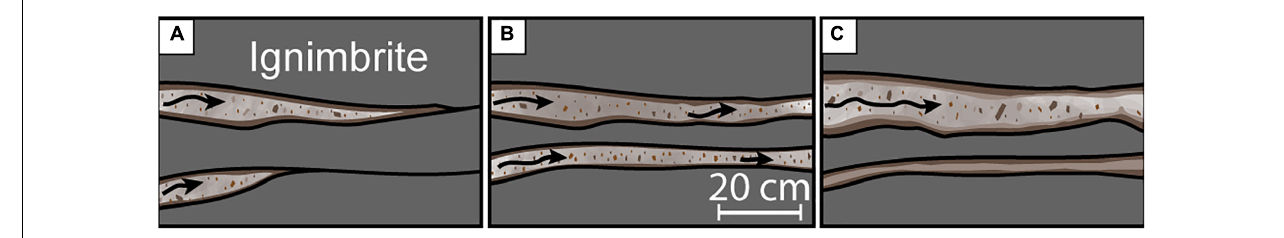
FIGURE 10 | Schematic showing the formation of interfingered tuffisite veins and sheets (Structure 4). (A) The fluid opens multiple pathways along weaknesses in the ignimbrite, allowing for fluid flow and particle deposition in each fracture. (B) Material is deposited inside each fracture, with fine material first deposited at the edges and coarser material toward the centre. (C) Fractures are interlinked, and through time dominant fluid pathways form, widening certain fractures while others narrow and become clogged with